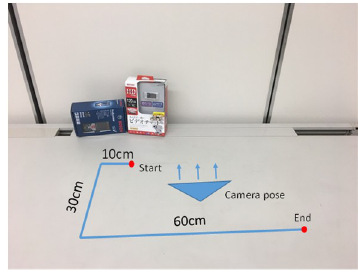
Figure 8. A measured route in a sparse environment.